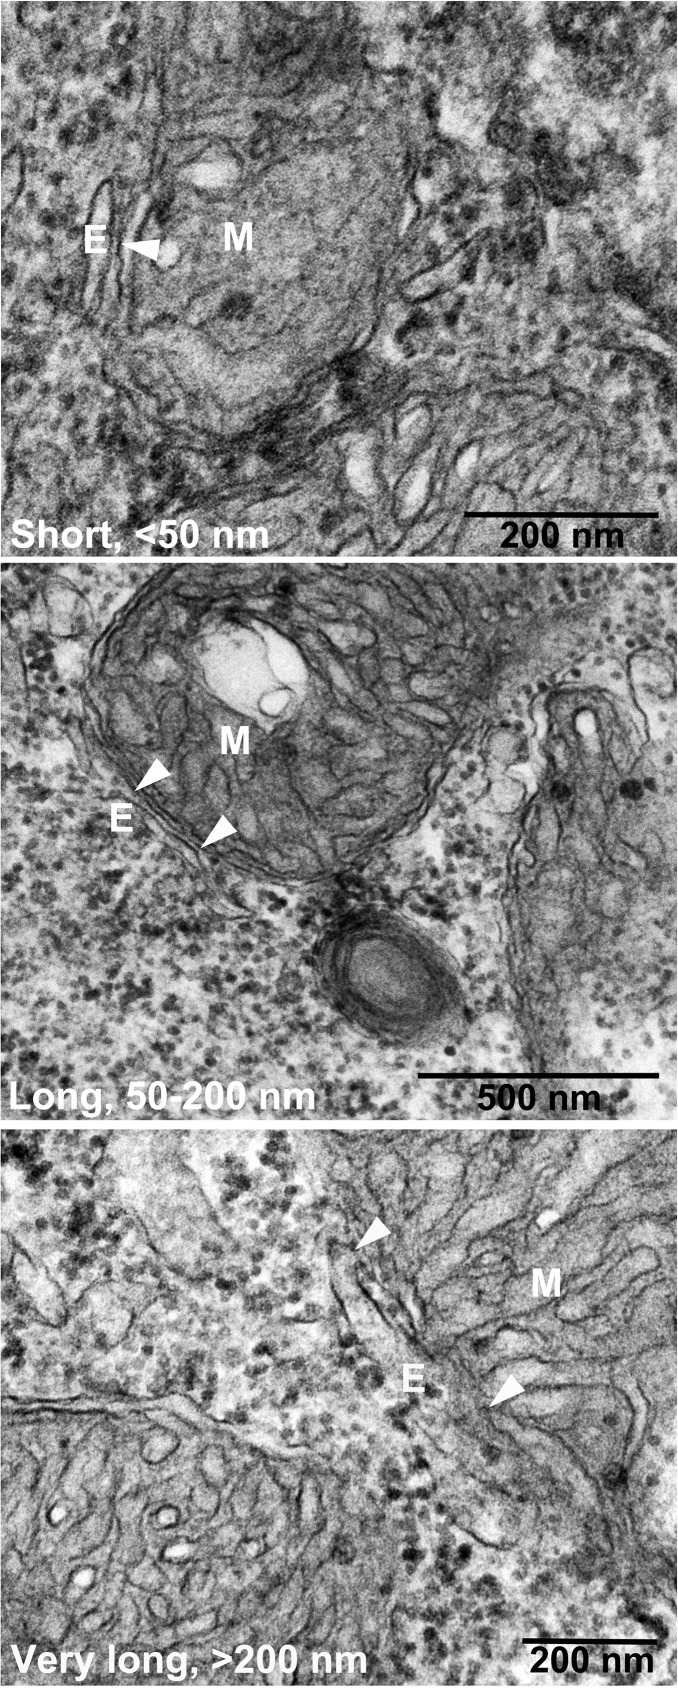
Electron microscopy of zebrafish neural cells.Cells were treated with morpholinos binding the start codon of psen1 and psen2 mRNA (MoPS1Tln and MoPS2Tln respectively). Arrowheads indicate the region of apposition between mitochondria (M) and endoplasmic reticulum (E) i.e. MAM.